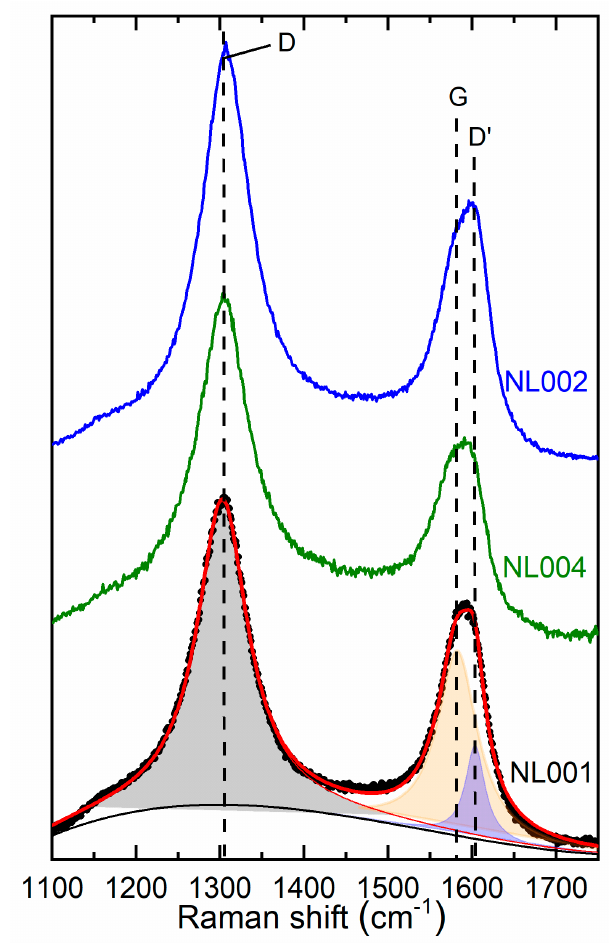
Figure 3. Indicative Raman spectra of the NL001, NL002, NL004 products where the characteristic D, G and D’ Raman bands are